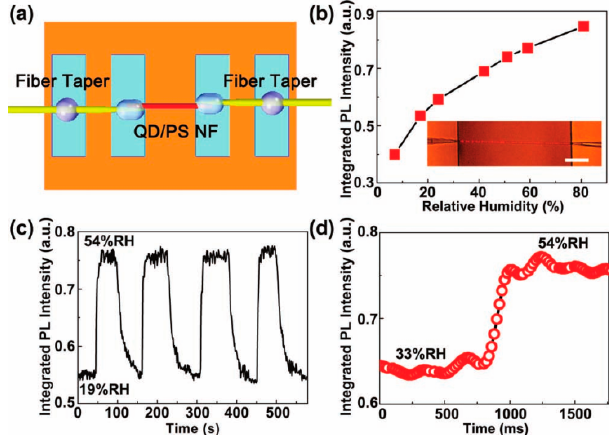
Figure 17. Quantum dot (QD)/polystyrene (PS) single-nanofiber humidity sensor. ( a ) Schematic diagram. ( b ) Integrated PL intensity of the polymer nanofiber exposed to relative humidity (RH) from 7% to 81%. Inset: microscopy image of the polymer nanofiber upon light excitation used in the sensor. ( c ) Response of the nanofiber sensor to alternately changed relative humidity of air from 54% to 19%. ( d ) Time-dependent integrated PL intensity of the nanofiber when relative humidity jumped from 33%